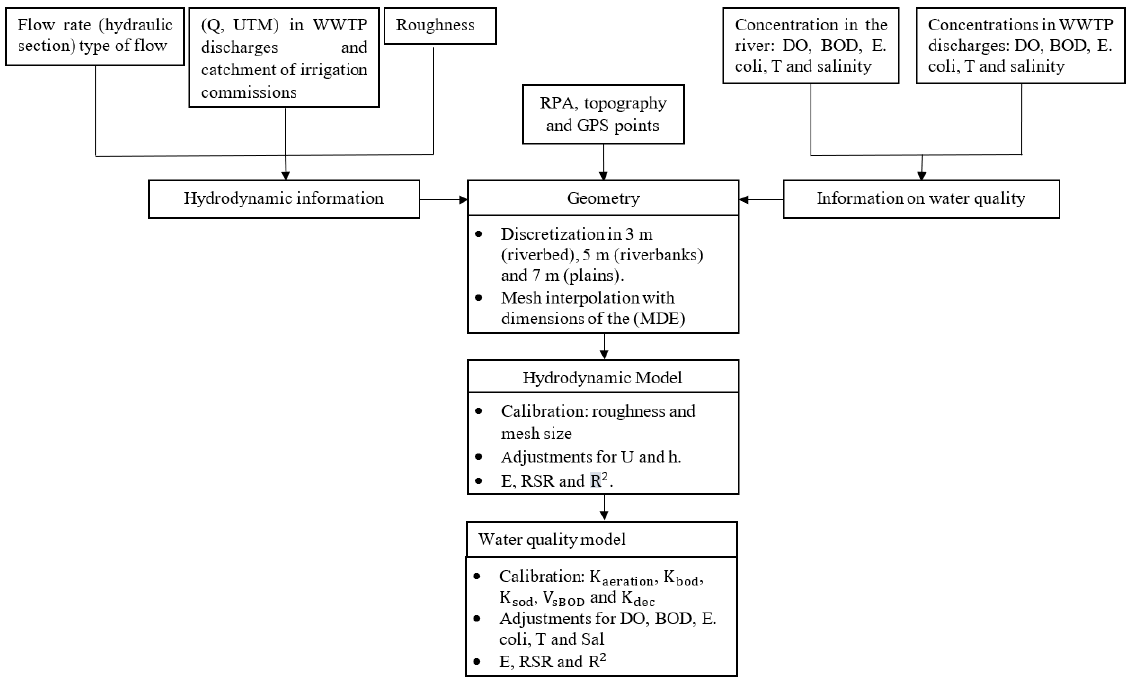
Figure 3. Flowchart of the methodology used in the study. WWTP is Waste Water Treatment Plant, RPAS is Remotely Piloted Aircraft System.